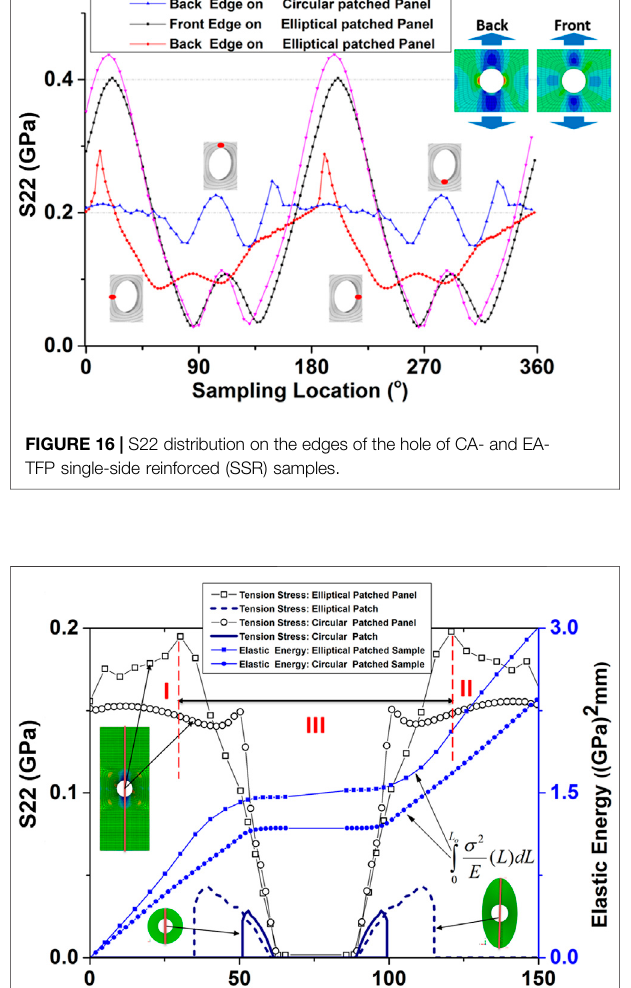
Frontiers in Materials |